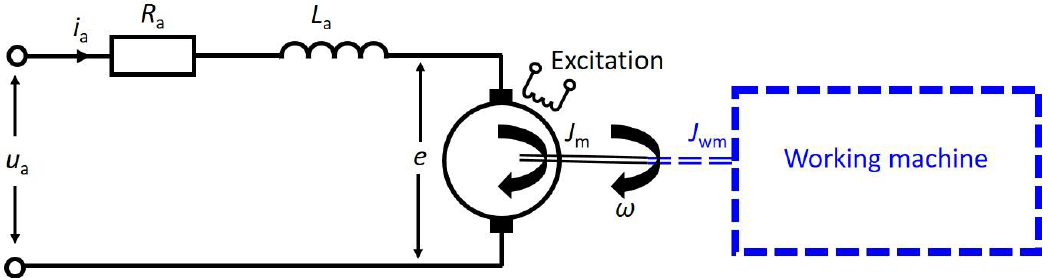
Figure 1. Schematic presentation of the drive composed of a DC motor with separate excitation and a working machine.